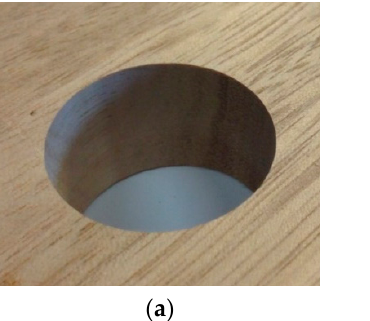
(good) ( b ) for boring tear-out.